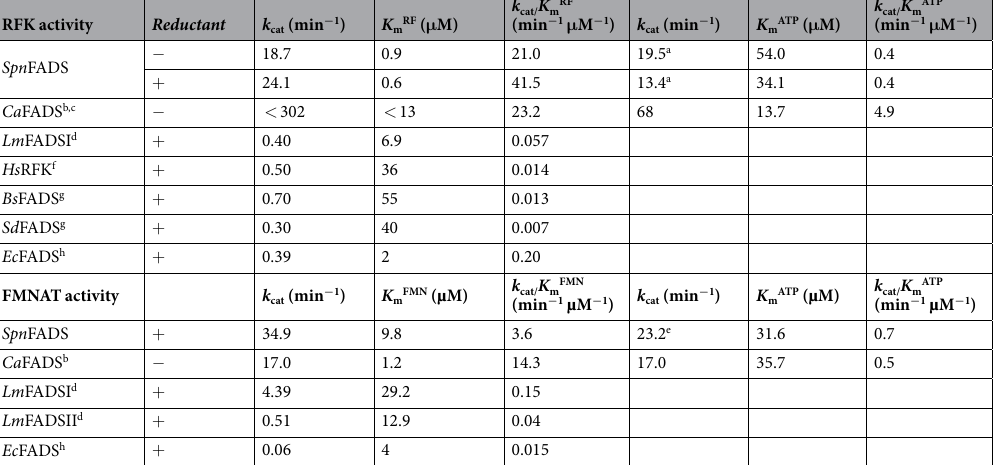
Table 1. Steady-state kinetic parameters for the RFK and FMNAT activities of Spn FADS. Parameters obtained at 25 °C in 20 mM PIPES, pH 7.0, 0.8 mM MgCl 2 and, when indicated 3 mM sodium dithionite as reductant. Estimated errors in k cat and K m are within ± 10%. a k cat measured at 6 μ M of RF. b Data from 33 . Data were obtained at 25 °C in 20 mM PIPES, pH 7.0 and 0.8 mM and 10 mM MgCl 2 , respectively, for the RFK and FMNAT activities. c Inhibition by substrate prevented the determination of true parameters and these correspond to apparent constants, k cat , app , K m , appRF , K m , appATP , k cat , app / K m , appRF and k cat , app / K m , appATP . d Data from 35 . Data obtained in 50 mM potassium phosphate, pH 7.5. e k cat measured at 27.7 µ M of FMN. f Data from 42 . Data obtained